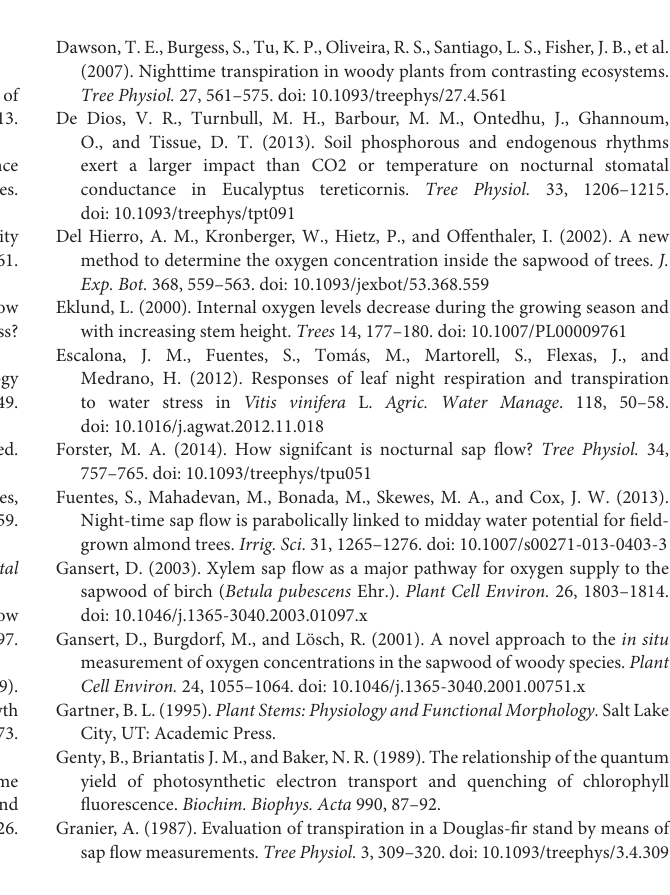
Supplementary Figure 1 | The seven studied tree species with stem photosynthesis: Castanopsis hystrix (a) , Michelia macclurei (b) , Eucalyptus citriodora (c) , Eucalyptus grandis × urophylla (d) ; and without stem photosynthesis: Castanopsis fissa (e) , Schima superba (f) , and Acacia auriculiformis (g)